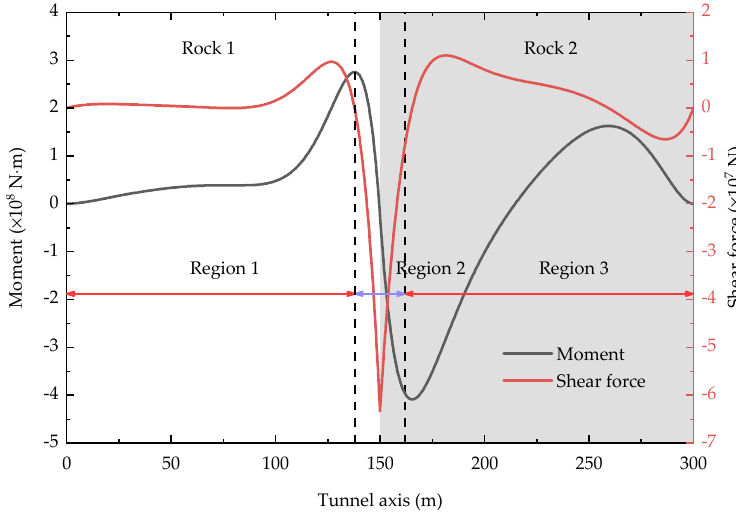
Figure 4. Responses of a tunnel buried in non-homogeneous ground (case 1).